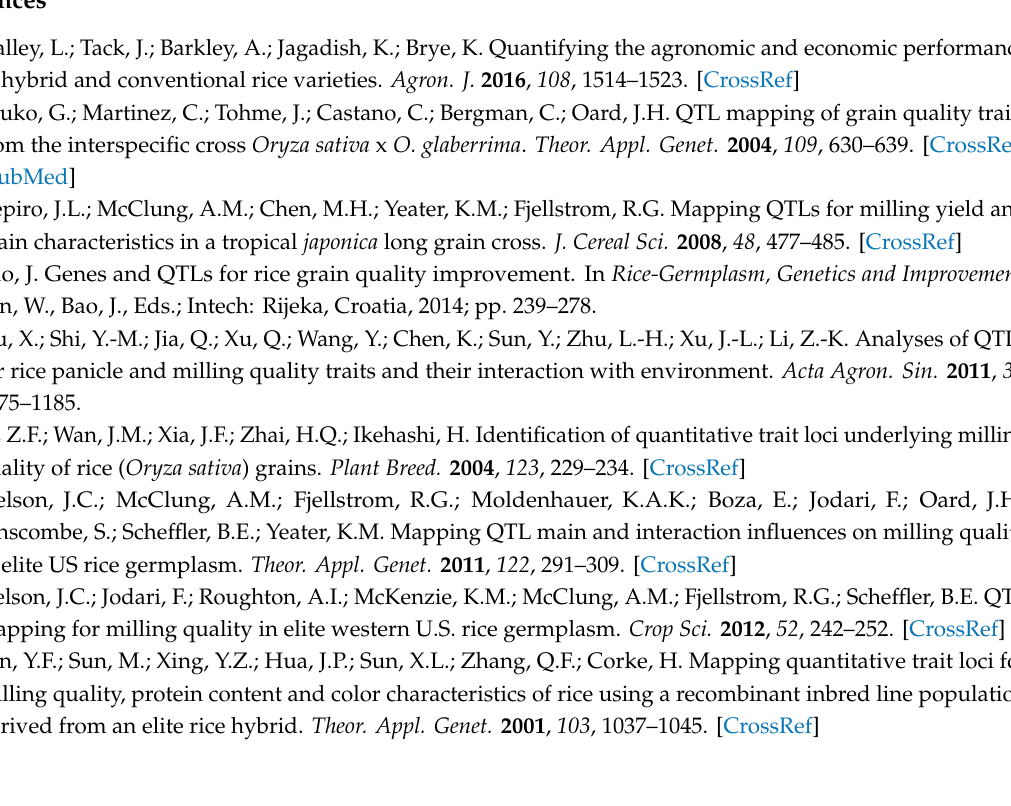
Figure S1: Frequency distribution of seven traits in three RIL populations. Table S1: Phenotypic performance of seven traits in the three RIL populations. Table S2: Simple correlation coe ffi cients between seven traits in the RH-F 4:5